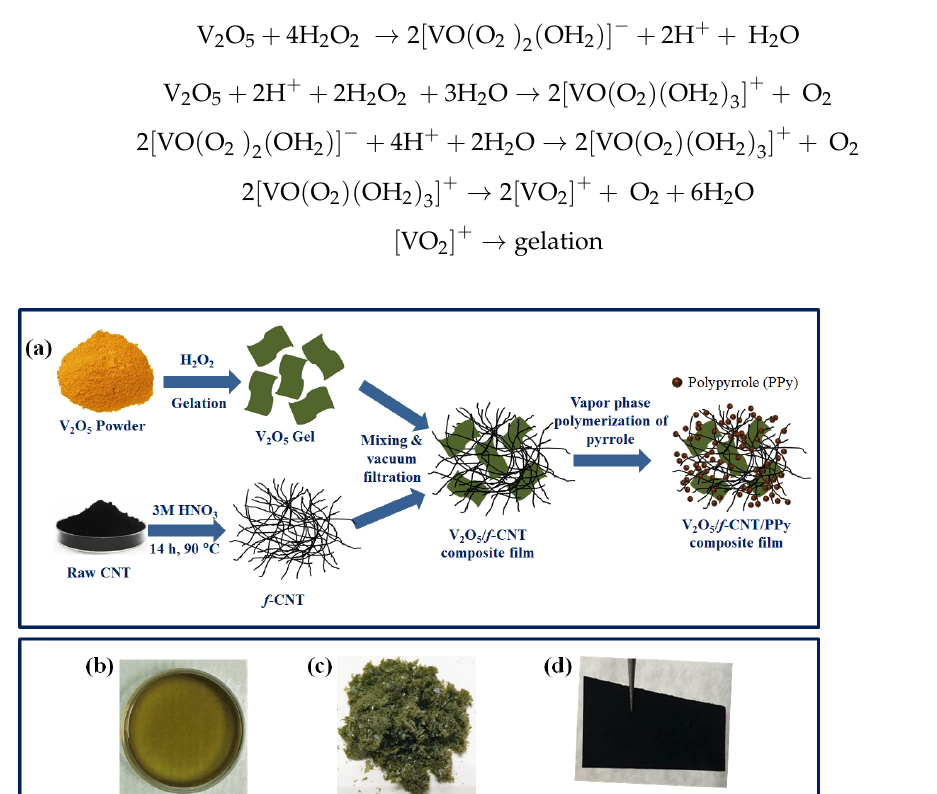
Figure 1. ( a ) schematic diagram of V 2 O 5 / f -CNT/PPy composite film fabrication process; photographs of ( b ) V 2 O 5 gel, ( c ) freeze dried V 2 O 5 gel, and ( d ) V 2 O 5 / f -CNT/PPy composite